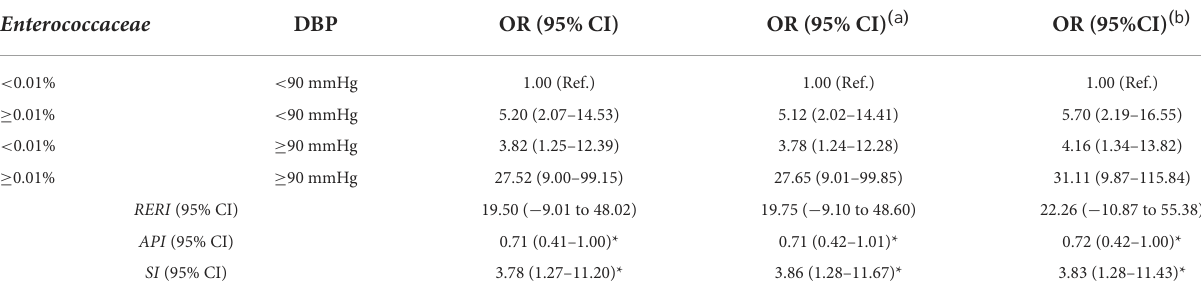
TABLE 3 Additive interaction analysis between DBP and family Enterococcaceae for first-ever ischemic stroke.